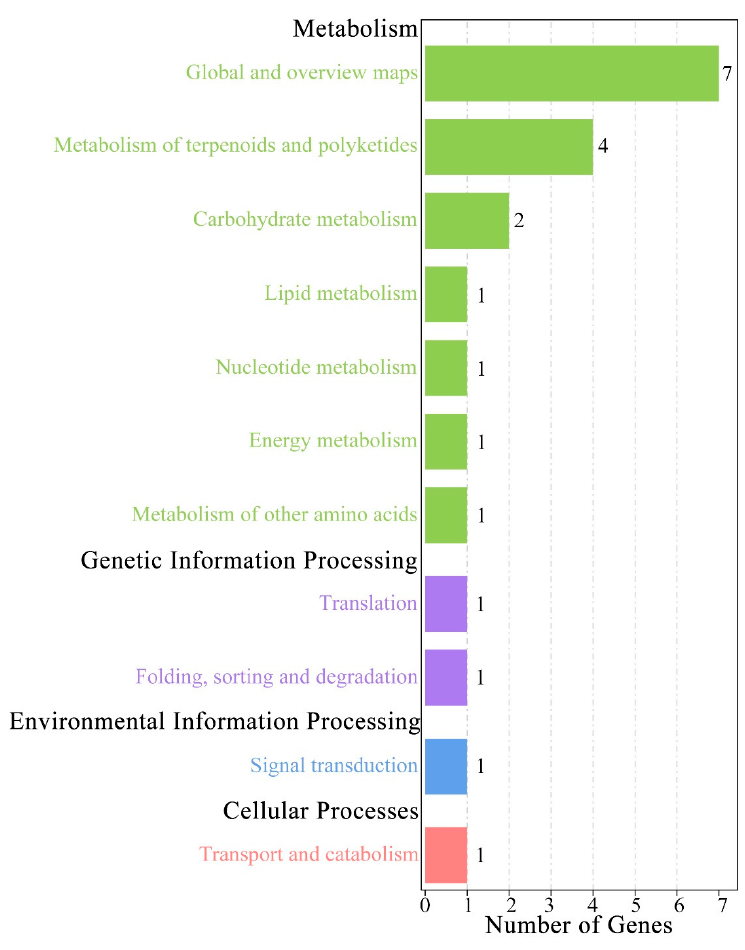
Figure 6. Results of a KEGG analysis of the associated